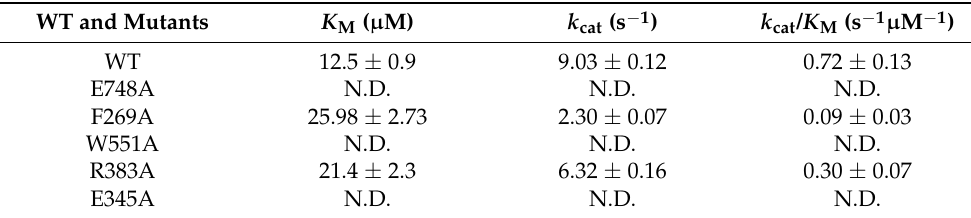
Table 2. Enzymatic activity assay for wild-type (WT) and mutant Kdh enzymes. The assays were carried out in Tris-HCl, pH = 8.0.